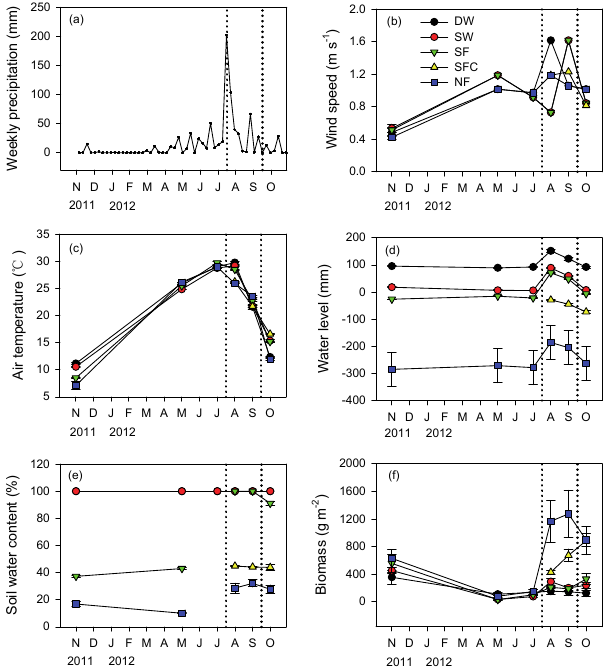
Figure 2. Environmental characteristics (mean ± SE) of each sam- pling area. Some SE bars are not visible. Days between dotted lines were the high water level period and thus the seasonal flooded site (SF) was under water. DW: deep water site; SW: shallow water site; SF: seasonally flooded site; SFC: “control site” for the seasonally flooded site; NF: non-flooded site. There were no soil water content data for July because of instrument malfunction.